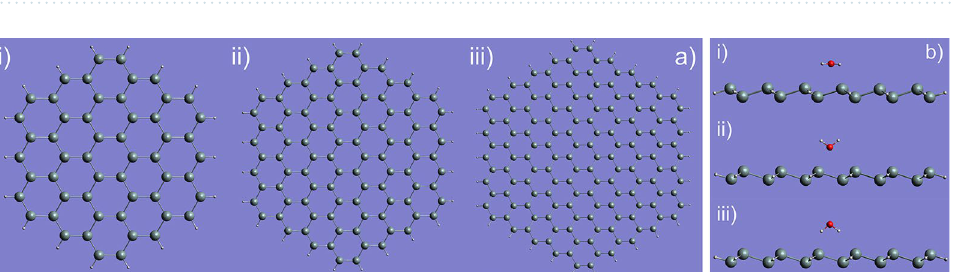
Figure 1. The simulation process for the pure SND and the absorption of a water molecule and a square ice on the SND.